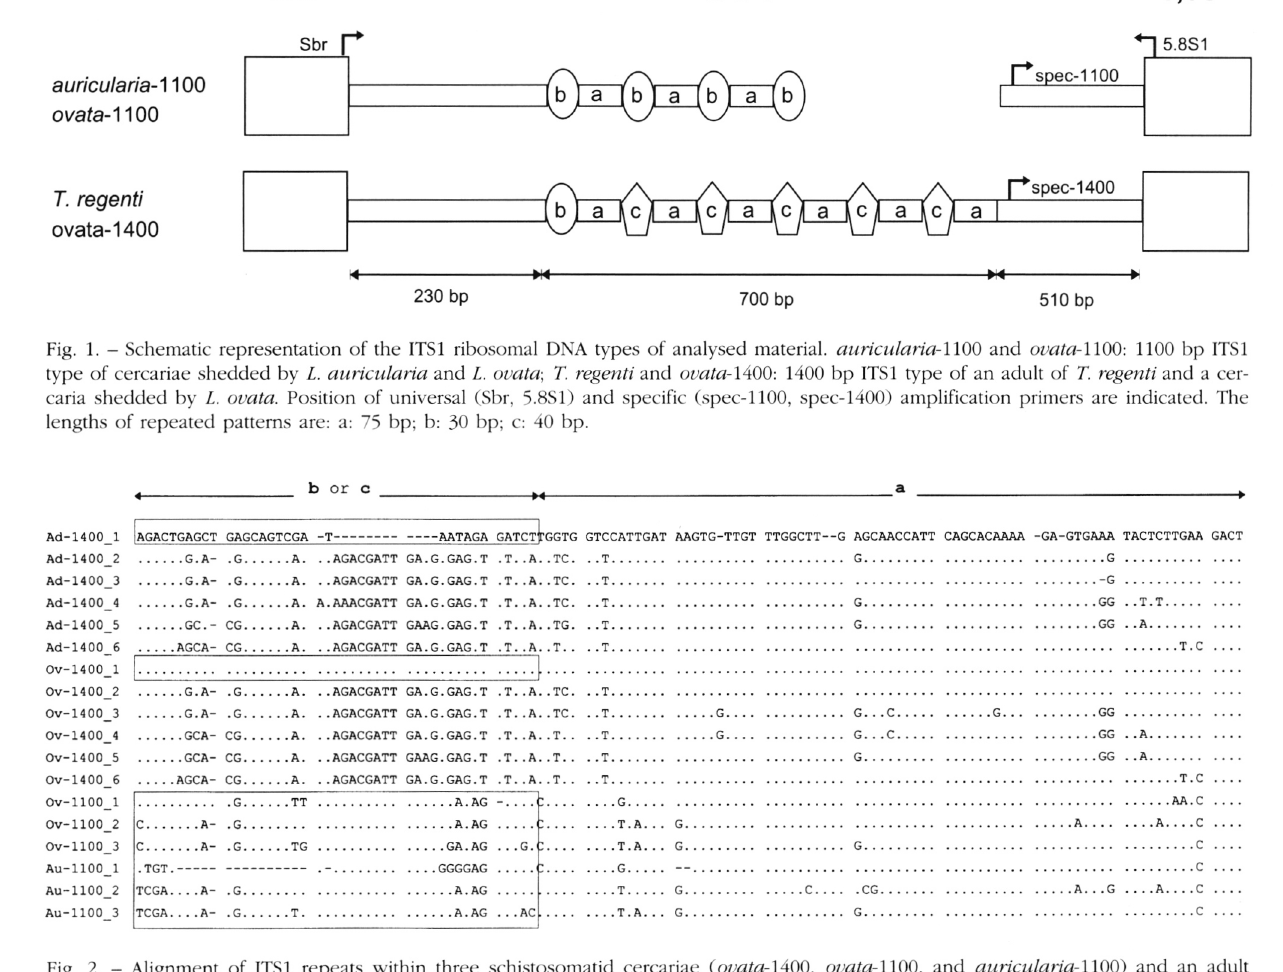
Fig. 2. - Alignment of ITS1 repeats within three schistosomatid cercariae (ovata-1400, ovata- 1100, and auricularia- 1100) and an adult (T. regenti) shown in figure 1. indicates the same base as shown on upper line; indicates alignment gaps. The position of repeated patterns (a, b, c) is indicated. Sequences inside boxes correspond to the pattern “b”, which is partially deleted in the first repeat of the cercaria shedded by L. auricularia (Au-1100_l). Ad-l400_l-6: ITS1 repeats from an adult of T. regenti infecting Anas platyrhynchos,